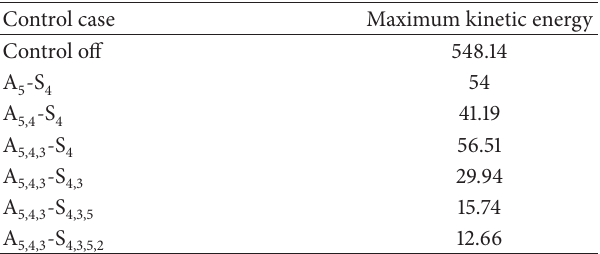
Table 6: The maximum kinetic energy for the five-story shear building subjected to the harmonic load.